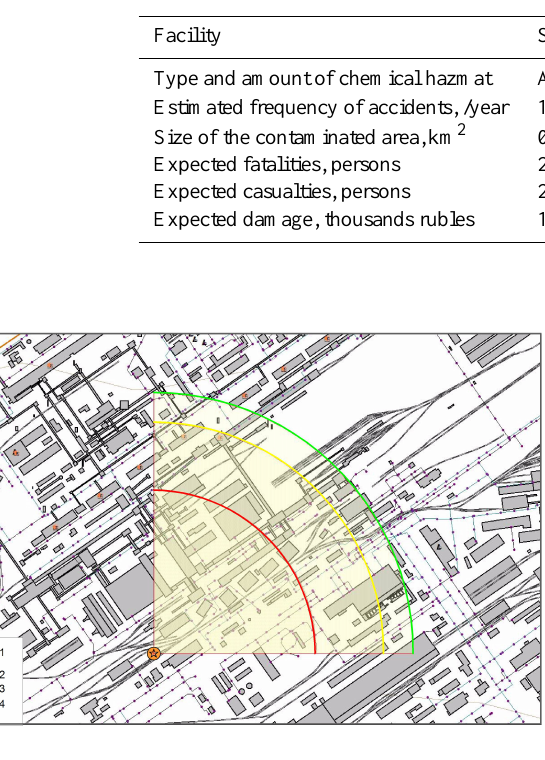
Fig. 6. Simulation of possible contaminated zones in the case of an accident with chemical material release: 1 – source of release of 3.0tons liquid chlorine; 2 – after 1h; 3 – after 3h and 4 – after 4h.